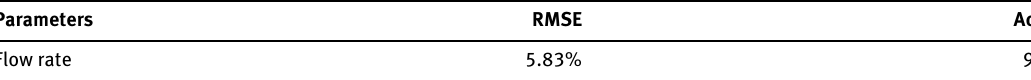
Table 4: RMSE for Cross-validation.